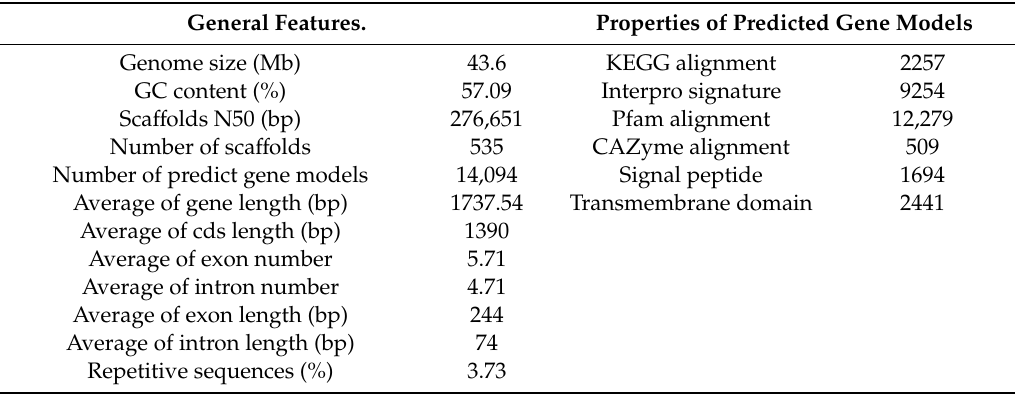
Table 1. Features of the Auricularia heimuer